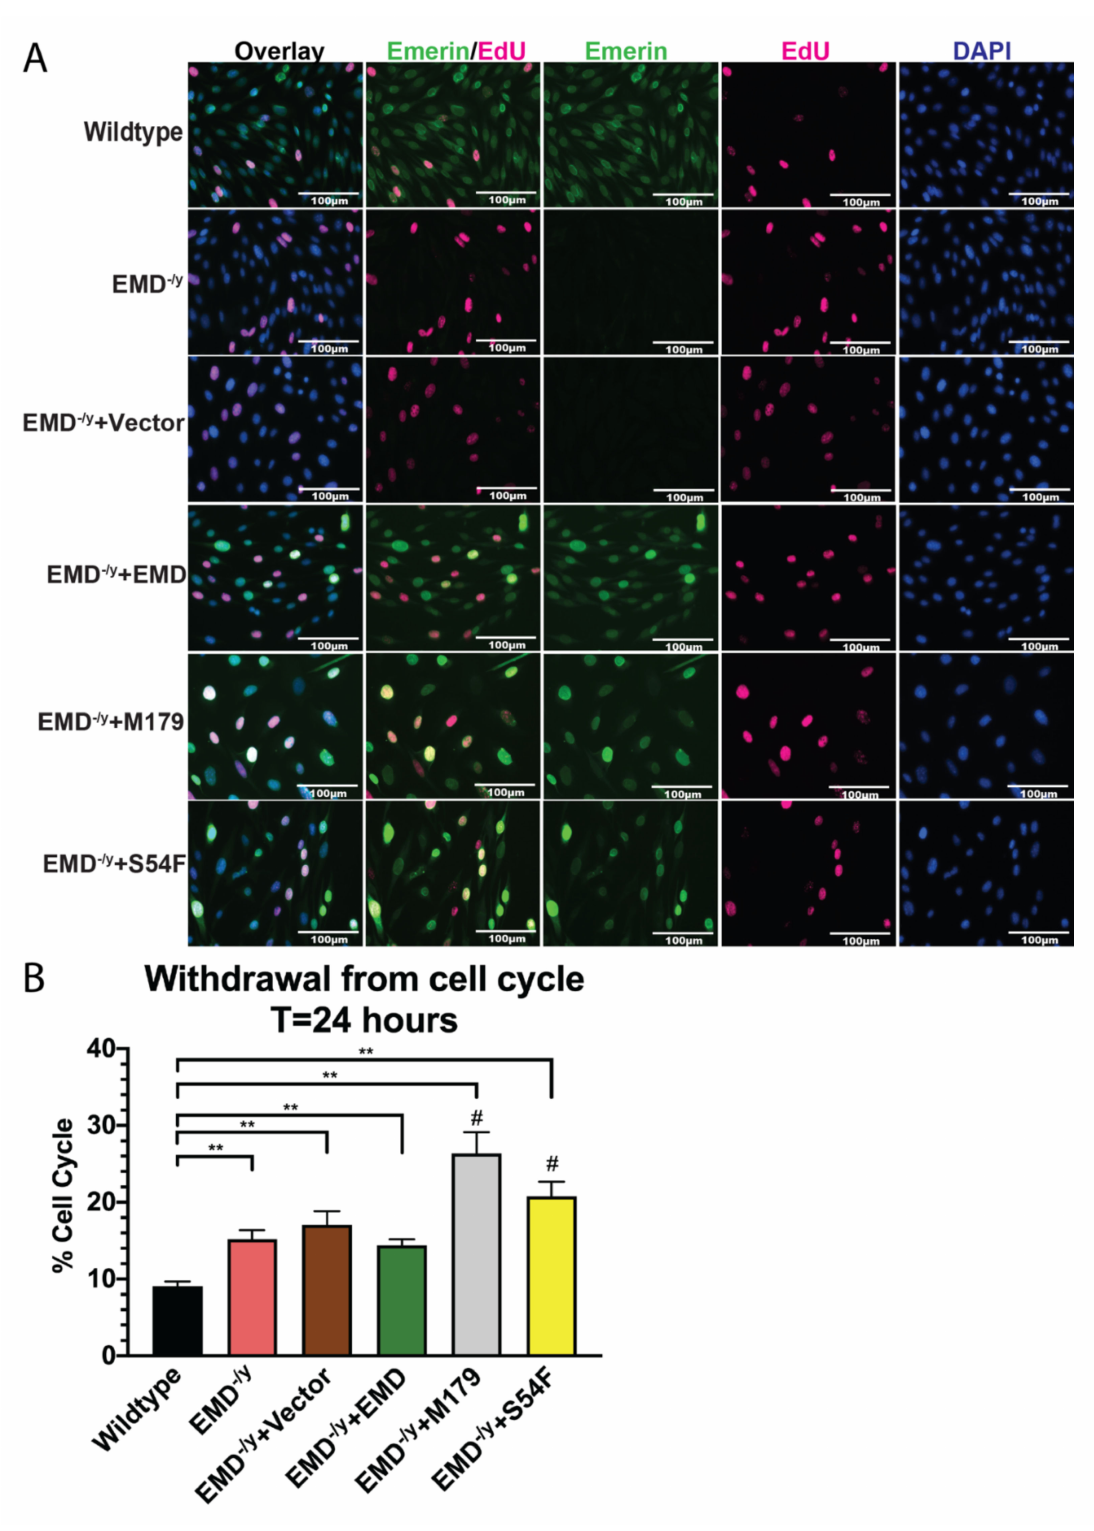
Figure 2. S54F and M179 emerin mutant myogenic progenitors fail to exit the cell cycle. ( A ) Immunofluorescence images at 24 h post di ff erentiation induction. Emerin is shown in green, EdU is shown in pink, and nuclei are blue. Scale bar: 100 µ m. ( B ) Cell cycle withdrawal at 24 h post di ff erentiation induction. ** p < 0.02; # p < 0.05 in comparison to +